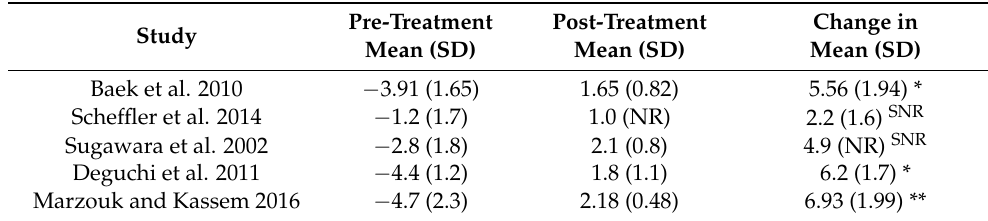
Table 8. The change in overbite measured on the incisors as a result of anterior open bite treatment by molar intrusion using skeletal anchorage (mm).